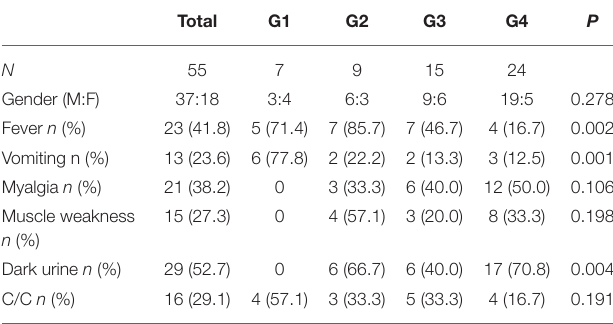
TABLE 1 | Classification of clinical manifestations of RM among